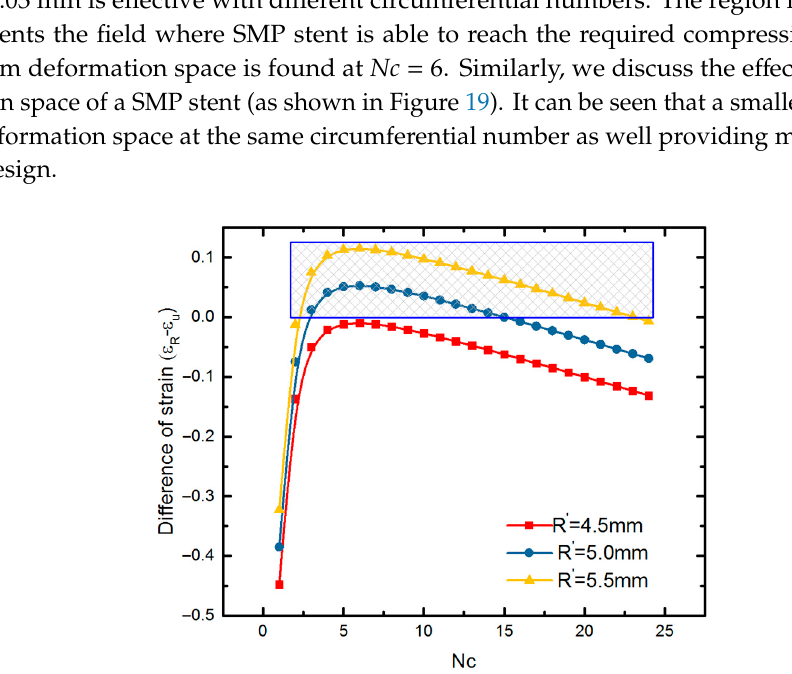
Figure 18. Difference of required strain and ultimate strain of the SMP stent with a radius for different programmed radii.